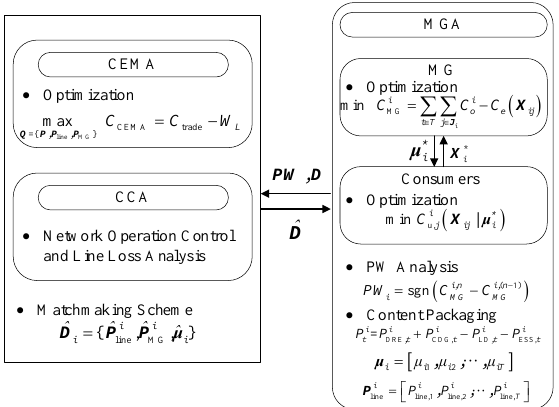
Figure 2. Coordination diagram of microgrid agent (MGA), central energy management agent (CEMA), and coordination control agent (CCA).